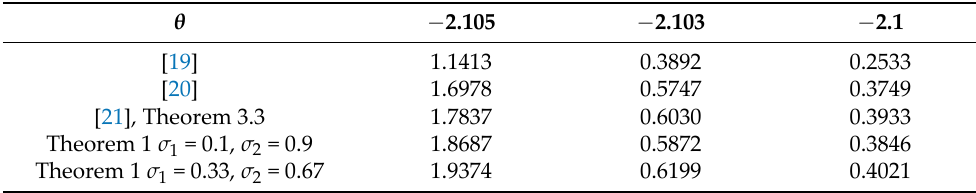
Table 2. Maximum Upper Bounds of τ for Different θ .